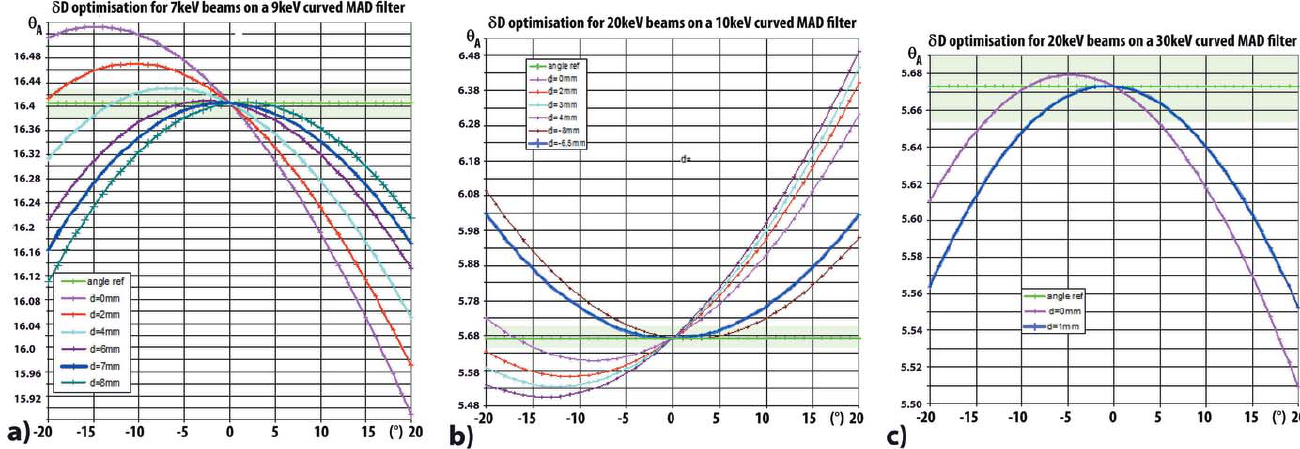
Figure 5 Optimization of the distance D (cid:6) (cid:4) D between the source/sample and the Laue mode curved MAD system; for some small (cid:4) D displacements, representations of the real values (thin colour curves) of the Bragg angles (cid:2) A , compared with the ideal values (green lines) (calculated for a beam of 7, 20 then 20 keV, arriving on an analyser having a curvature optimized for 9, 10 then 30 keV, respectively). ( a ) Variation of Bragg angles (cid:2) A according to different D (cid:6) (cid:4) D distances for a 7 keV beam arriving on an analyser having a curvature optimized for 9 keV. ( b ) Variation of Bragg angles (cid:2) A for a 20 keV beam arriving on an analyser with a curvature optimized for 10 keV. ( c ) Variation of Bragg angles (cid:2) A for a 20 keV beam arriving on an analyser with a curvature optimized for 30 keV. For these three energy ranges (7–9 keV, 10–20 keV and 20–30 keV), close to Cu K (cid:2) 1 , Mo K (cid:2) 1 and Ag K (cid:2) 1 laboratory X-ray sources, a small displacement (cid:4) D (7 mm, (cid:6) 6.5 mm and 1 mm, respectively) widens the accessible angular range of filtering ( (cid:4) 20 (cid:3) , (cid:4) 15 (cid:3) or (cid:4) 20 (cid:3) , respectively) (dark blue